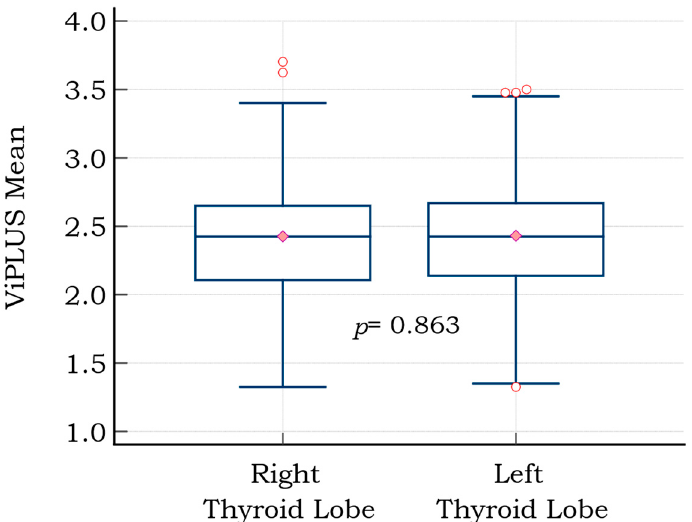
Figure 3. Graph comparison (box and whiskers) of mean viscosity plane-wave ultrasound (ViPLUS) values for the right and left thyroid lobes; the red circles are the graphical representation of outliers (extremely high, respectively extremely low values); the pink diamond marks the median value.